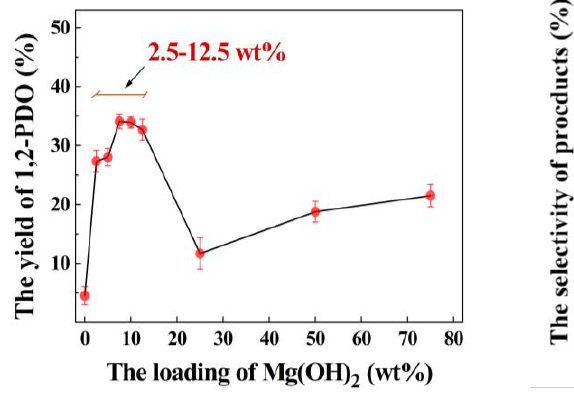
Figure 2. The effect of Mg(OH) 2 and Pt loading on glucose hydrogenolysis into 1,2-PDO. Reaction condition: catalyst (200 mg), glucose (11.25 mg/mL, 10 mL) and H 2 (initial 6 MPa) at 200 °C for 3 h.